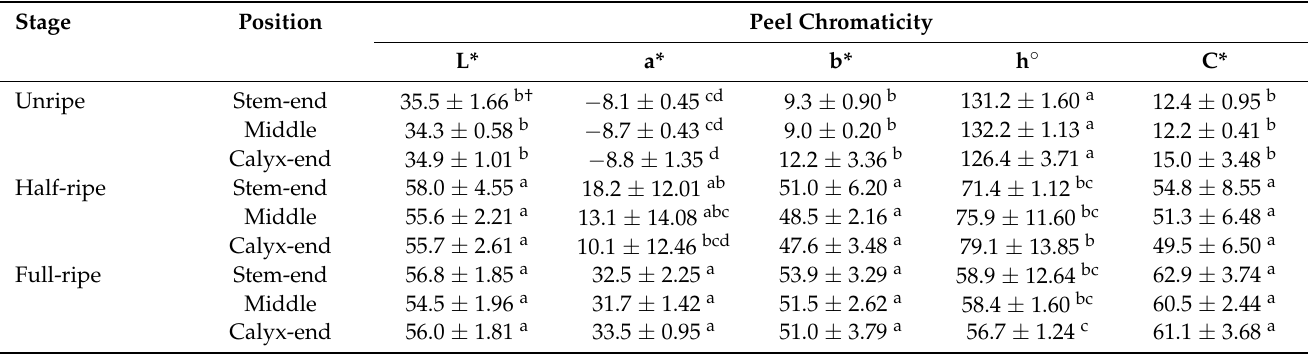
† Di ff erent le tt ers within columns indicate signi fi cant di ff erences by Duncan’s multiple range test at † Different letters within columns indicate significant differences by Duncan’s multiple range test at p < 0.05. L*—the lightness of colors, ranging from 0 to 100 (0, black; 100, white); a*—negative for green and positive for red; b*—negative for blue and positive for yellow; h ◦ —hue angle calculated as tan − 1 (b*/a*); C*—chroma calculated as (a* 2 + b* 2 ) ×